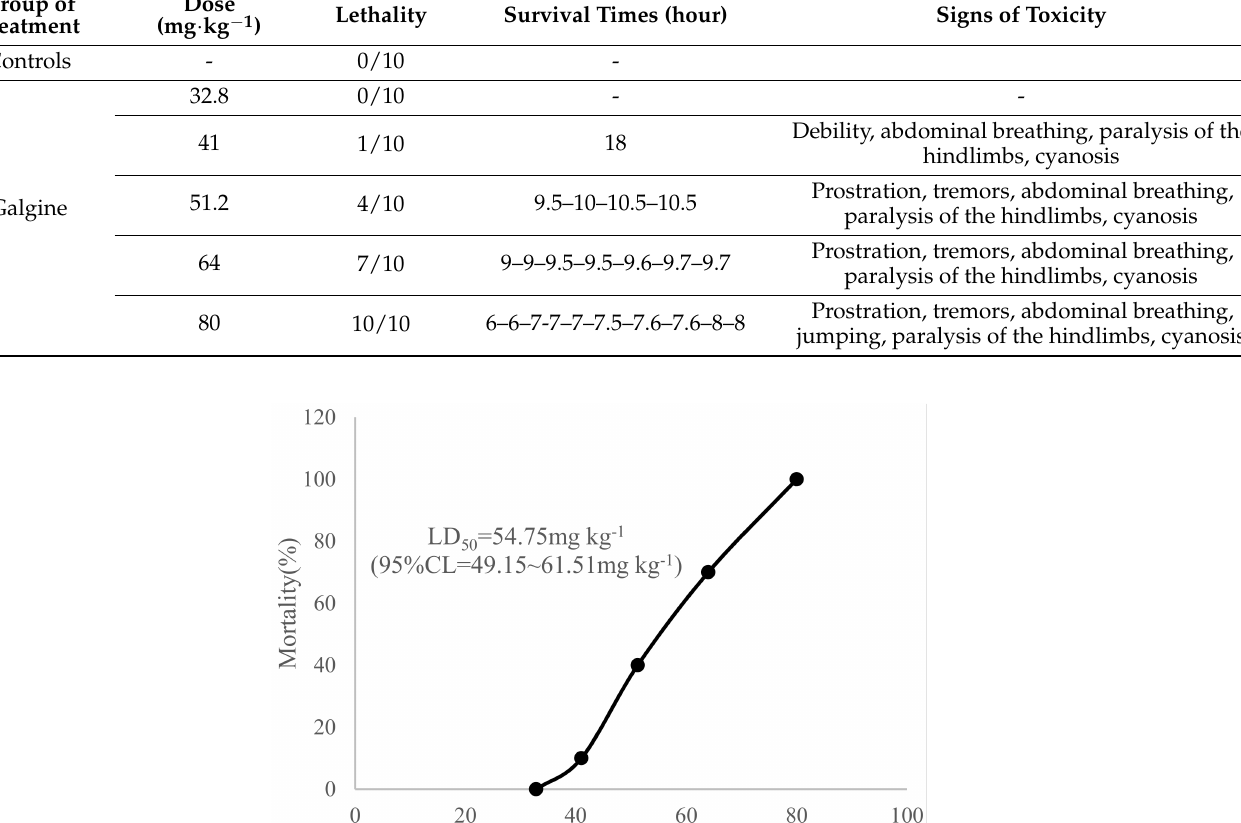
Table 2. Lethality and signs of toxicity of mice after intraperitoneal injection administration of galegine. Group of Treatment